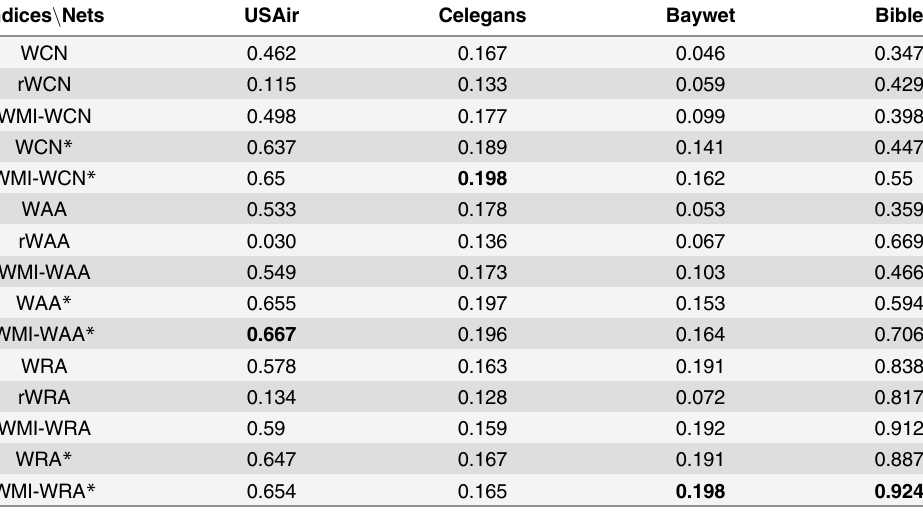
Table 3. Comparison of WMI-based methods with other typical weighted indices measured by Preci- sion (top-100) on four networks. Each value is obtained by averaging over 100 independent runs of random division of training set and probe set. The abbreviations WCN * , WAA * , WRA * , WMI-WCN * , WMI-WAA * and WMI-WRA * represent the highest Precision values shown in Fig 1 (please refer to detailed α values in Table 2). The best performance in each network is marked by bold